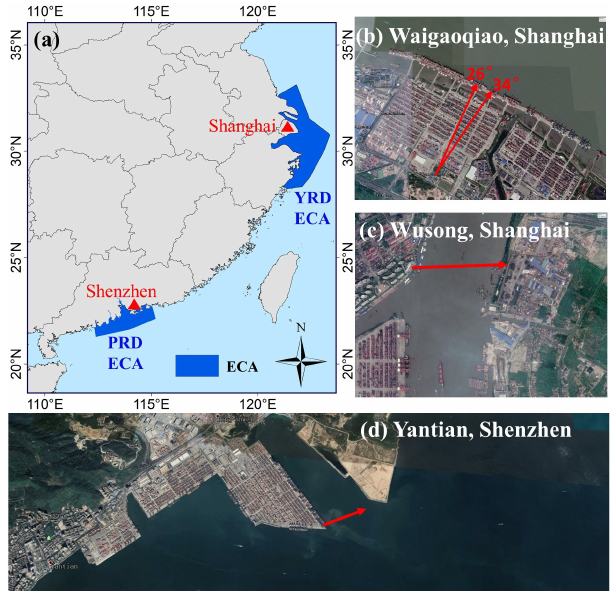
Figure 1. The YRD and PRD domestic emission control areas (DE- CAs) in China, and the locations of the MAX-DOAS measurements in the coastal cities of Shanghai and Shenzhen: Waigaoqiao Port and Wusong Wharf in Shanghai, and Yantian Port in Shenzhen. The viewing direction of instrument azimuth angle is indicated using a red arrow. Panels (b) to (d) are sourced from ©Google